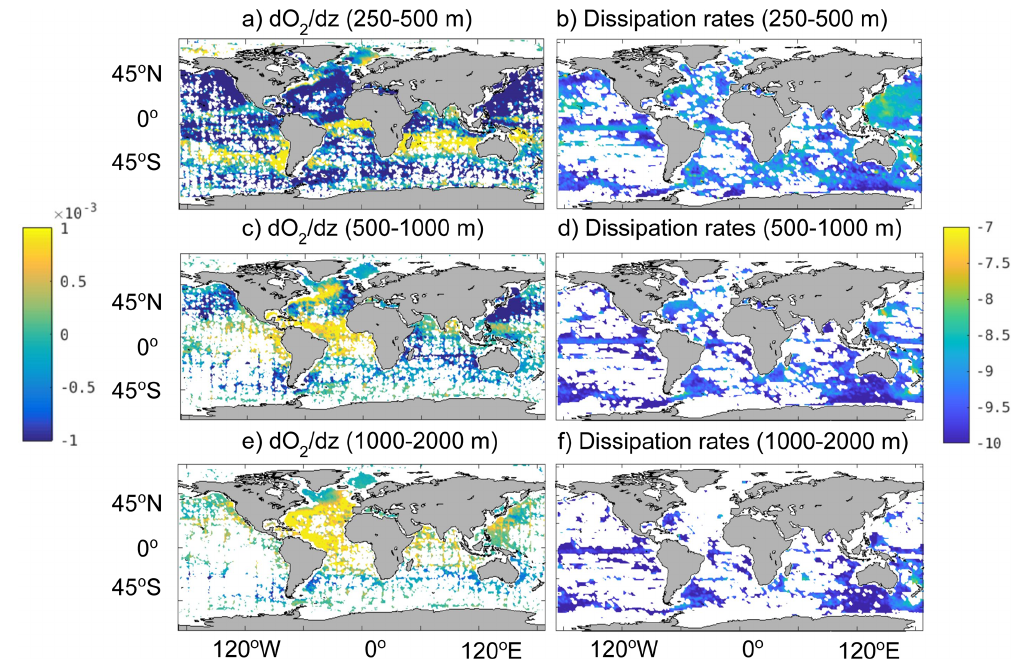
Figure 1. Shown are the vertical gradients of oxygen concentrations (units in mLL − 1 m − 1 ) from the World Ocean Atlas (2013) ( panels a , c , and e) and the base-10 logarithms of the dissipation rates (units in Wkg − 1 ) from Whalen et al. (2015) ( panels b , d , and f) . Panels (a) and (b) show an average over 250–500m depth. Panels (c) and (d) show an average over 500–1000m depth. Panels (e) and (f) show an average over 1000–2000m depth. White areas in the ocean indicate insufficient